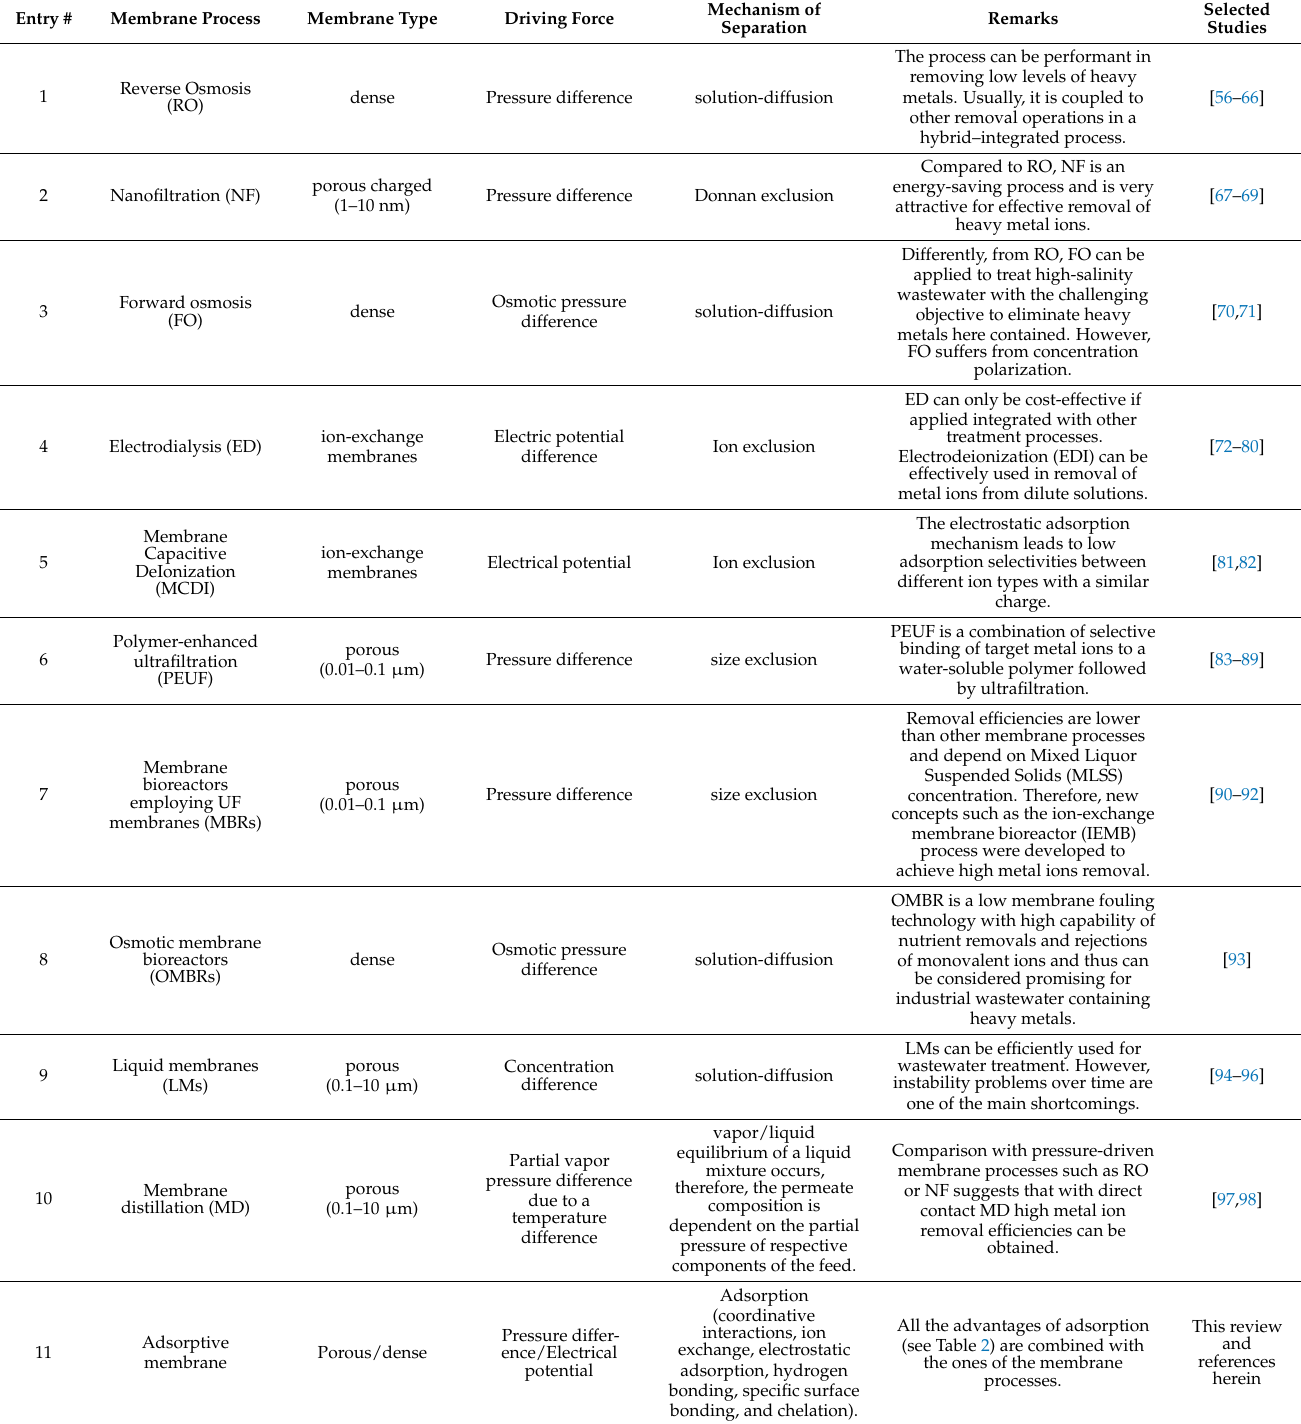
Table 3. Membrane processes for heavy metal ion